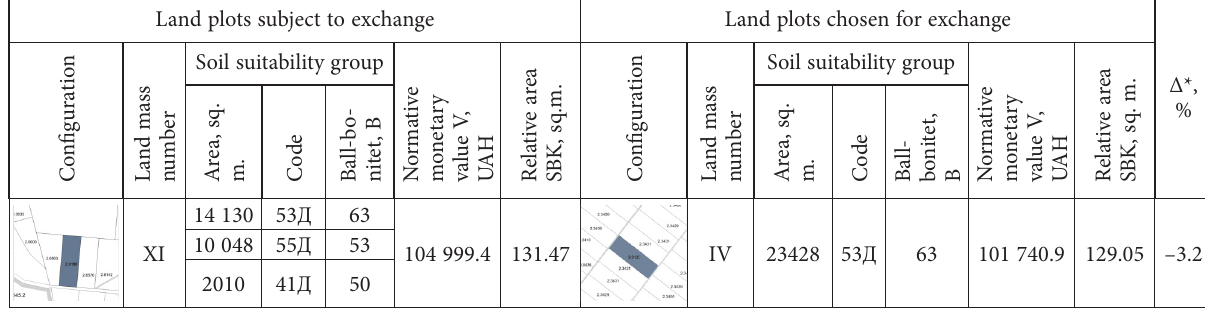
Table 2. Land plots exchange in the land consolidation project (option ІІ) Land plots subject to exchange Land plots chosen for exchange